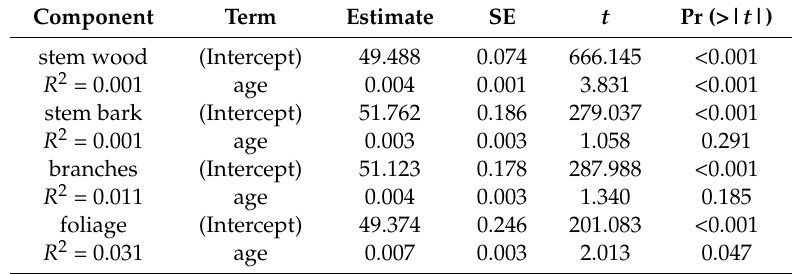
Table 6. Relationships between forest stand age and carbon content (%) assessed using linear regression. Component